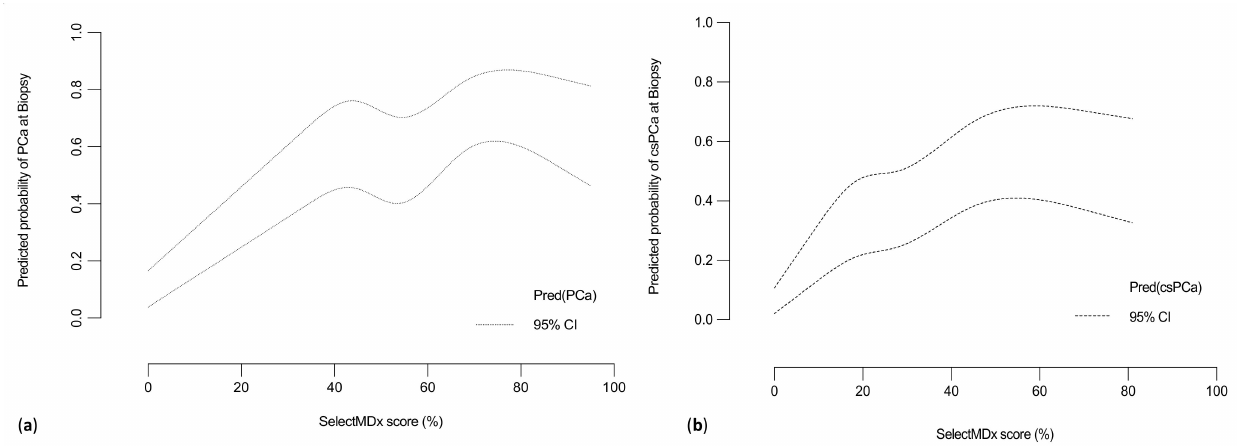
Figure 4. Multivariable adjusted Locally Weighted Scatter Plot Smoother (LOWESS) function depicting the predicted probability of ( a ) PCa or ( b ) csPCa detection rate and SelectMDx score (%). (PCa = prostate cancer; csPCa = clinically significant